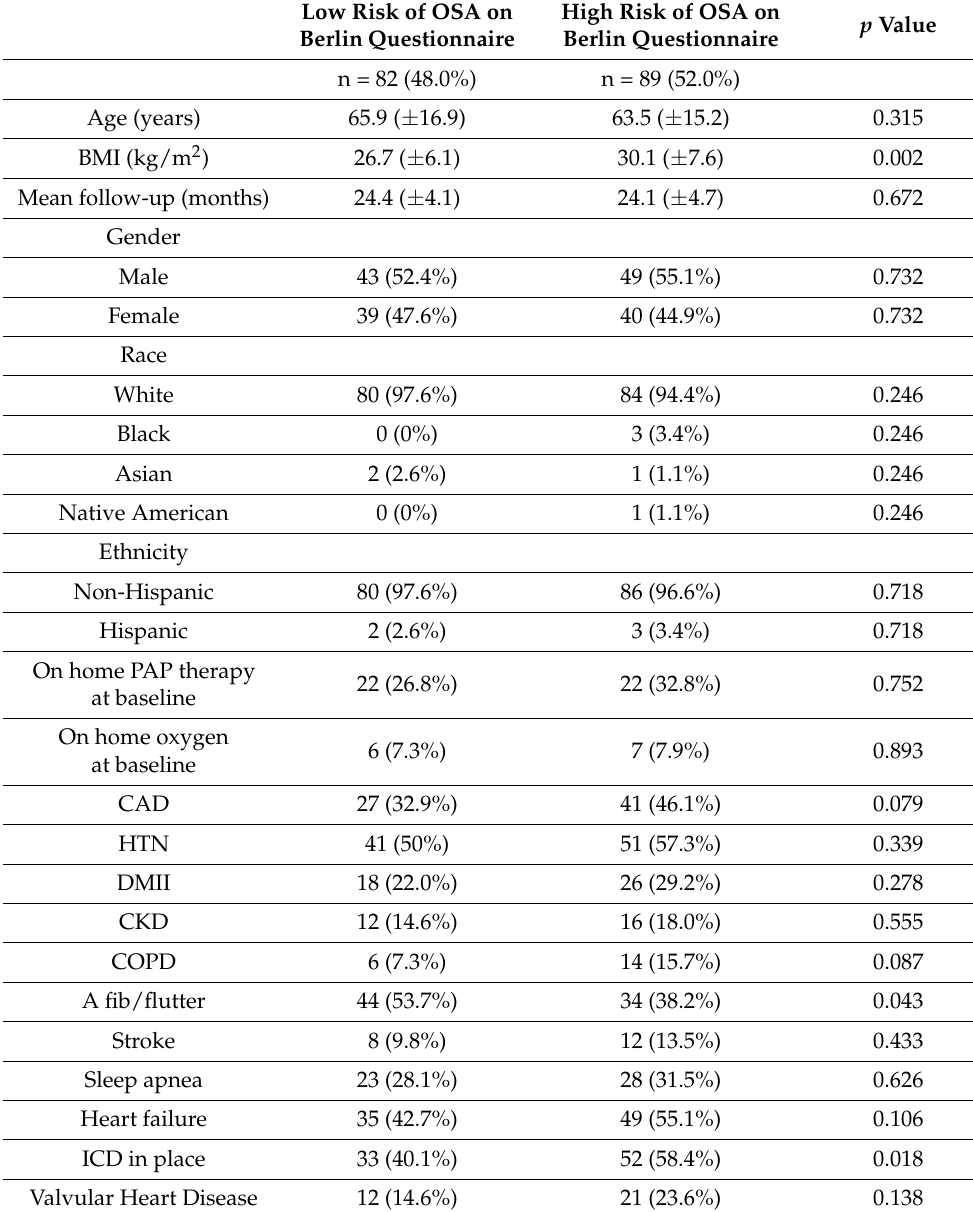
Table 1. Baseline characteristics of 171